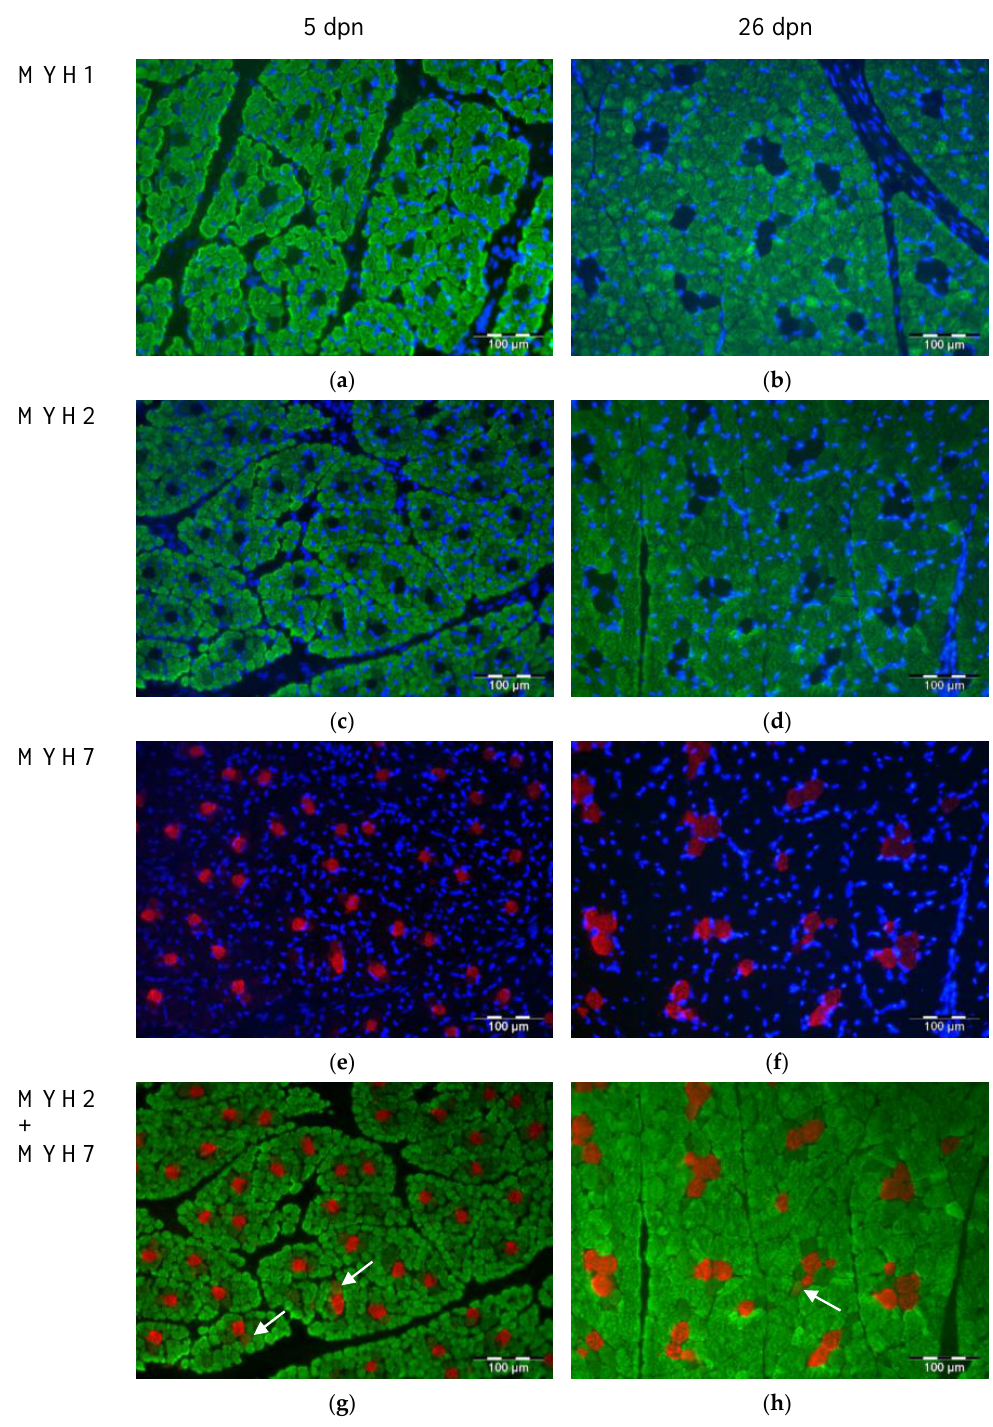
Figure 4. Localization of myosin heavy chain (MYH) isoforms within M. longissimus of piglets at 5 ( a , c , e , g ) and 26 dpn ( b , d , f , h ). MYH1 ( a , b ) and MYH2 ( c , d , g , h ) were stained green; MYH7 ( e – h ) was stained red. Nuclei were counterstained with Hoechst 33258 and appear in blue. Arrows in MYH2 and MYH7 double staining images ( g , h ) indicate transient fibers. Scale bar = 100 µm.